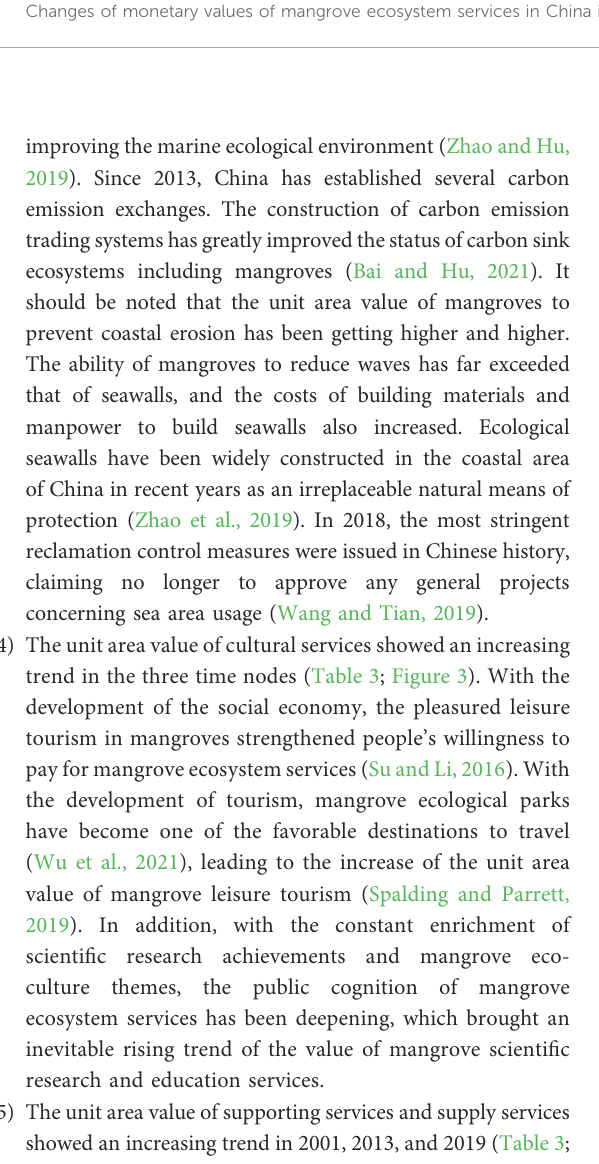
Figure 3). Supporting services are essential basic services of